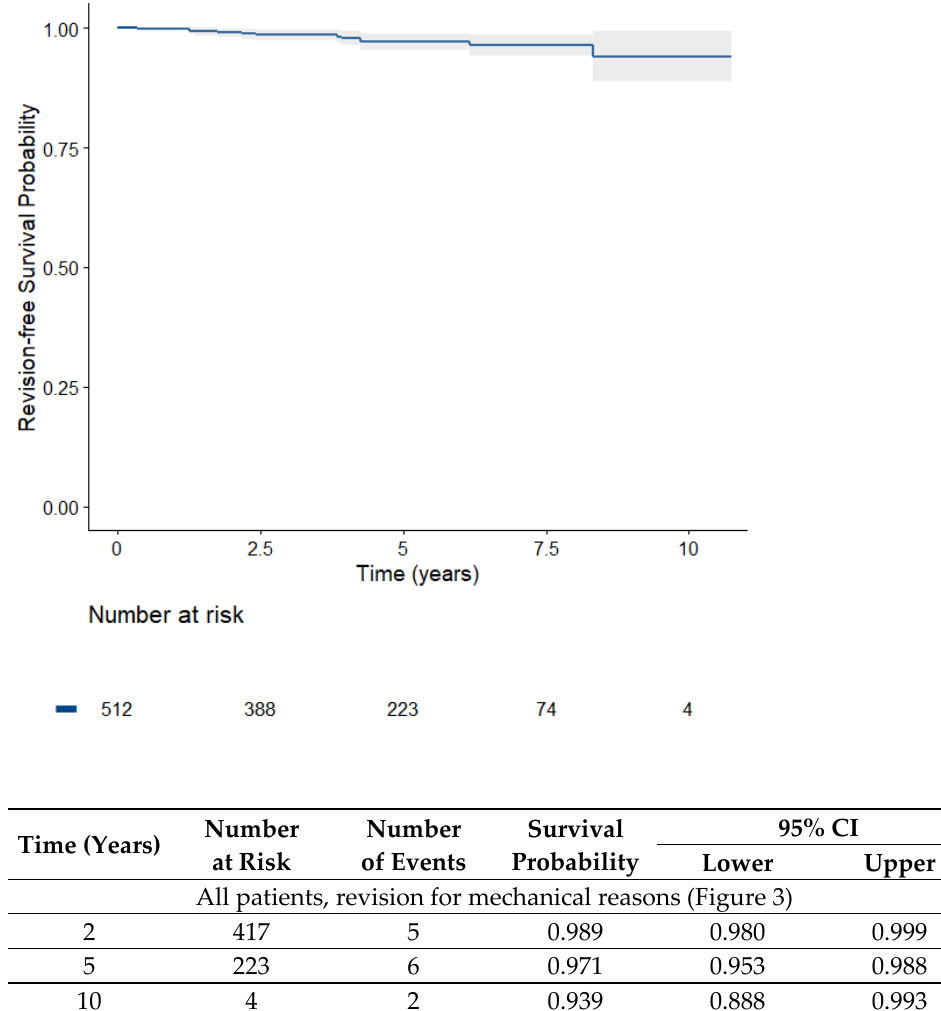
Figure 3. Kaplan–Meier survival analysis of all UKA (512 medial and lateral unicondylar knee prostheses) over time (overall survival with revisions for mechanical reason).